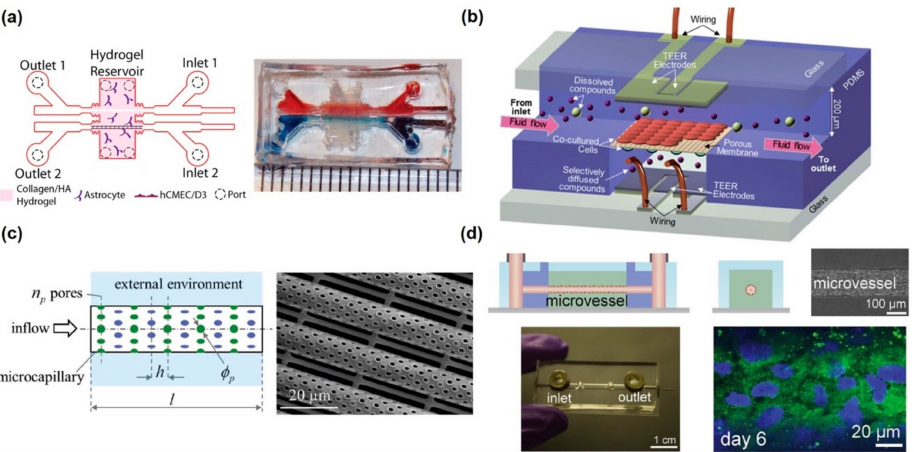
Figure 2. In vitro microfluidic-integrated BBB models. ( a ) Horizontal-aligned microfluidic BBB model with 3D hydrogel structure for induction of crosstalk between neuronal cells and